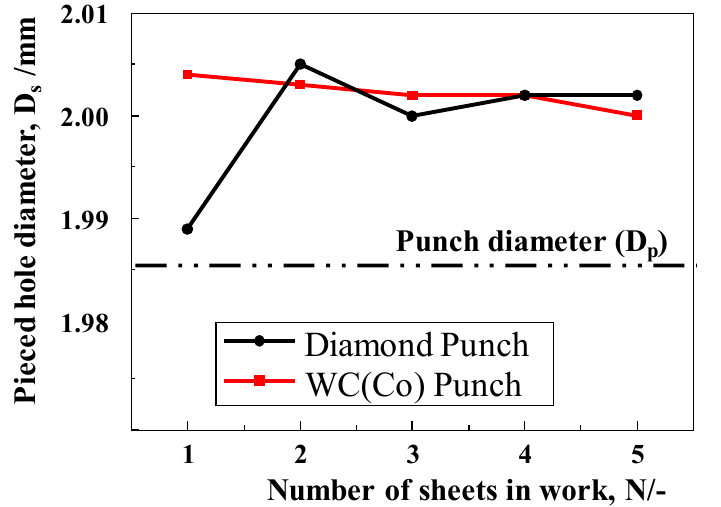
Figure 10. Deviation of the pierced hole inner-diameter among five electrical amorphous steel sheets when using two punches.